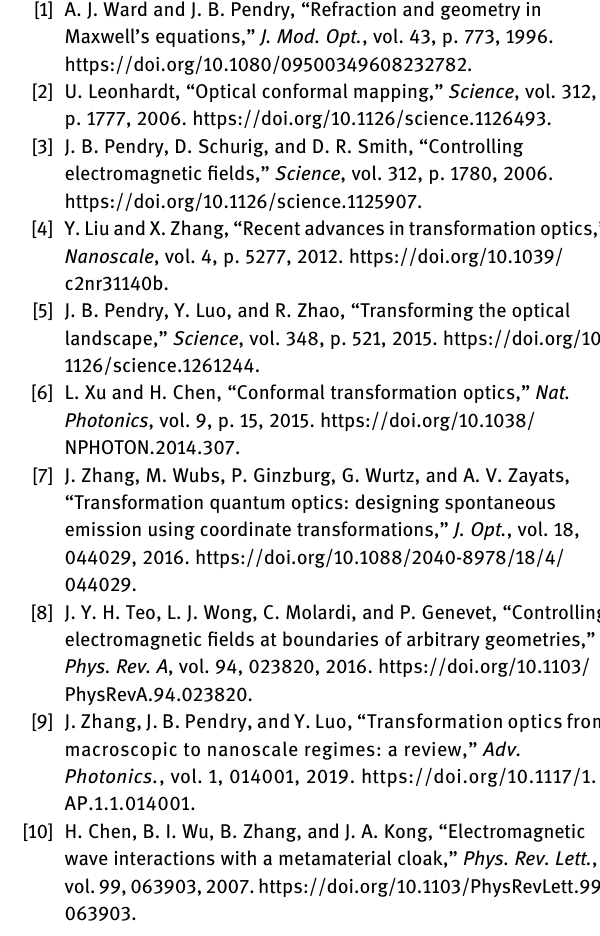
Figure 6: Demonstration of the absorber. Electric field distribution when a TE Gaussian beam is illuminated to the absorber with incident angle (A) 15 ° , (B) 25 ° , (C) 35 ° , (D) 45 ° . The absorption coefficient from f = 0.5 GHz to 3 GHz at different incident angles are plotted in (E). Electric fi eld distribution when a TE Gaussian beam is illuminated to the absorber with incident angle (F) 15 ° , (G) 25 ° , (H) 35 ° , (I) 45 ° . The absorption coef fi cient from f = 0.5 GHz to 3 GHz at different incident angles are plotted in